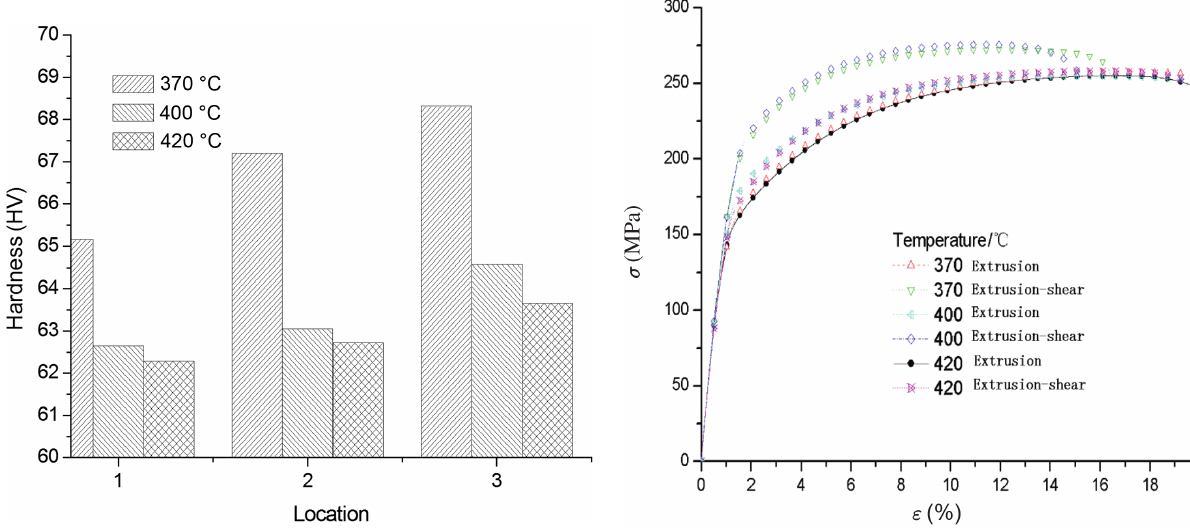
Figure 5: Micro-hardness of different position of rods fabricated by ES process (error range: 3HV).